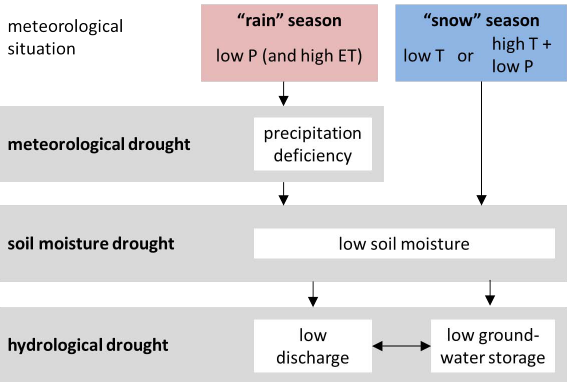
Fig. 1. Flow chart of drought propagation, based on Stahl (2001); Peters (2003); Van Loon and Van Lanen